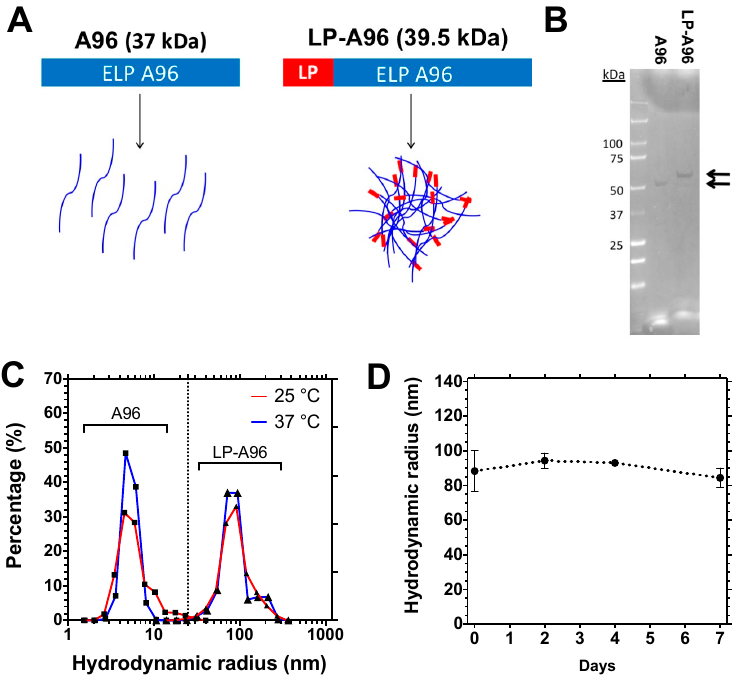
Figure 1. Lacripep promotes assembly of LP-A96 into stable, multivalent spherical nanoparticles. ( A )